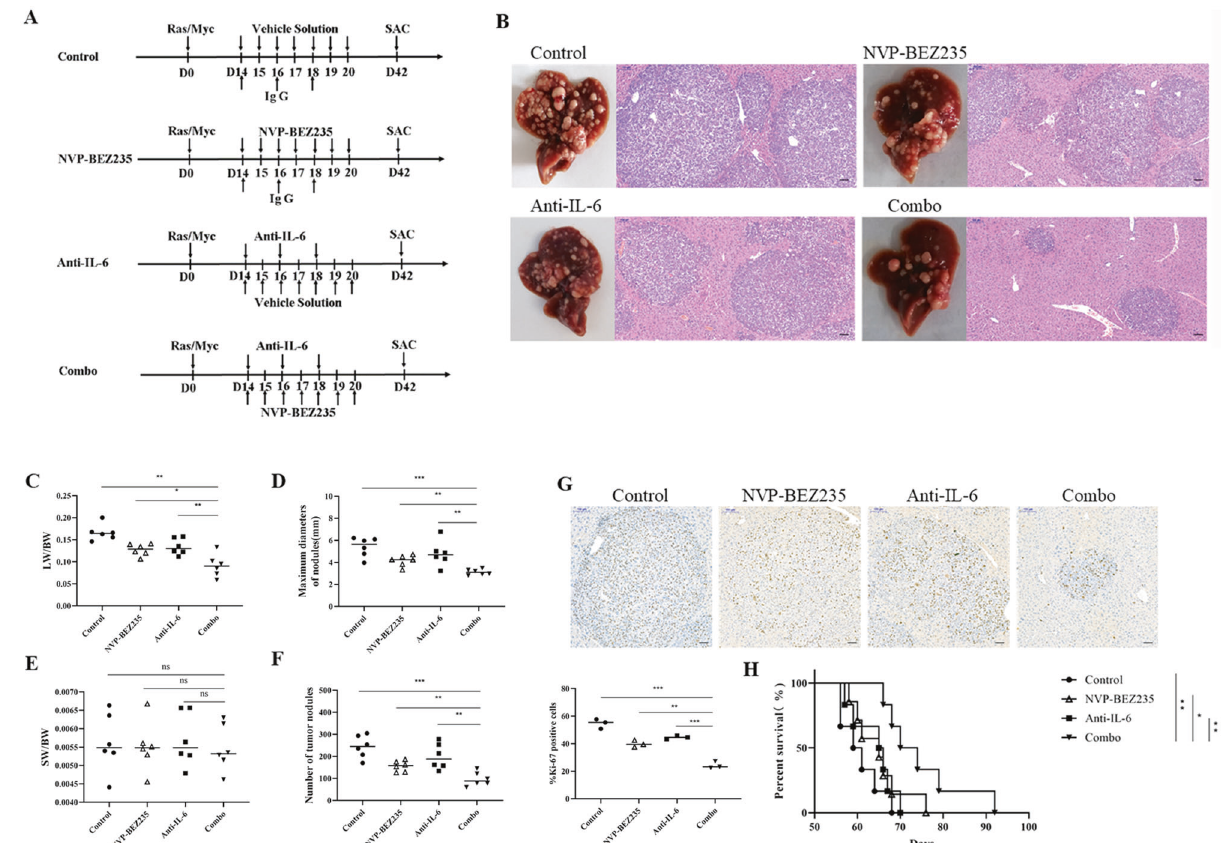
Fig. 7 NVP-BEZ235 combined with IL-6 antibody effectively inhibits tumour progression and prolongs the survival time in mice with HCC. A Scheme of the experimental procedure for NVP-BBEZ235, anti-IL-6 Ab, or the combination treatment. N-Ras/c-Myc/SB plasmids were transfected into all four groups of mice on Day 0. NVP-BBEZ235 (60 mg/kg) (or vehicle solution) was i.p. injected on Days 14-20, and anti-IL-6 Ab (or isotype IgG) was i.p. injected on Days 14, 16, and 18. All mice were euthanized 6 weeks after oncogene transfection. B Gross appearances of livers and H&E-stained liver sections in mice treated with NVP-BBEZ235, anti-IL-6 Ab, or their combination. Magni fi cation, 100×; scale bar, 100 μ m. C – F Tumour loads were evaluated by LW/BW ratios, SW/BW ratios, maximum diameter of nodules, and number of tumour nodules (mm). G Left: Representative immunostaining of Ki-67 tumour areas in liver sections. Magni fi cation, 100×; scale bar, 100 μ m. Right: Quanti fi cation of Ki67 + tumour cell numbers per fi eld. H Kaplan – Meier survival curves of overall survival of the four groups of mice. Log-rank test was performed, n = 6 per